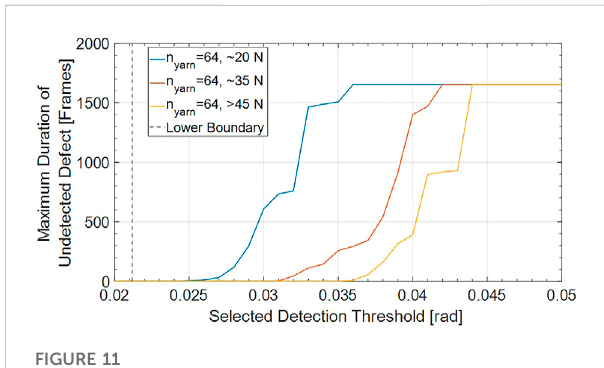
FIGURE 11 Duration of an undetected defect depending on different levels of yarn tension anomalies over selected difference in angular yarn distance as detection threshold for the case of n yarn (cid:1) 64 12 k